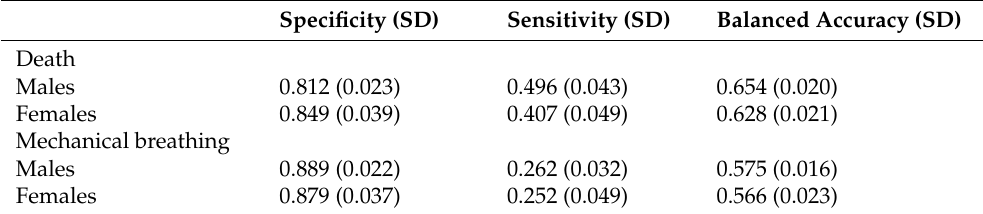
Table 5. Averaged model quality based on 100 holdout data splits. Shows specificity (true positive rate), sensitivity (true negative rate) and balanced accuracy for all evaluated regression